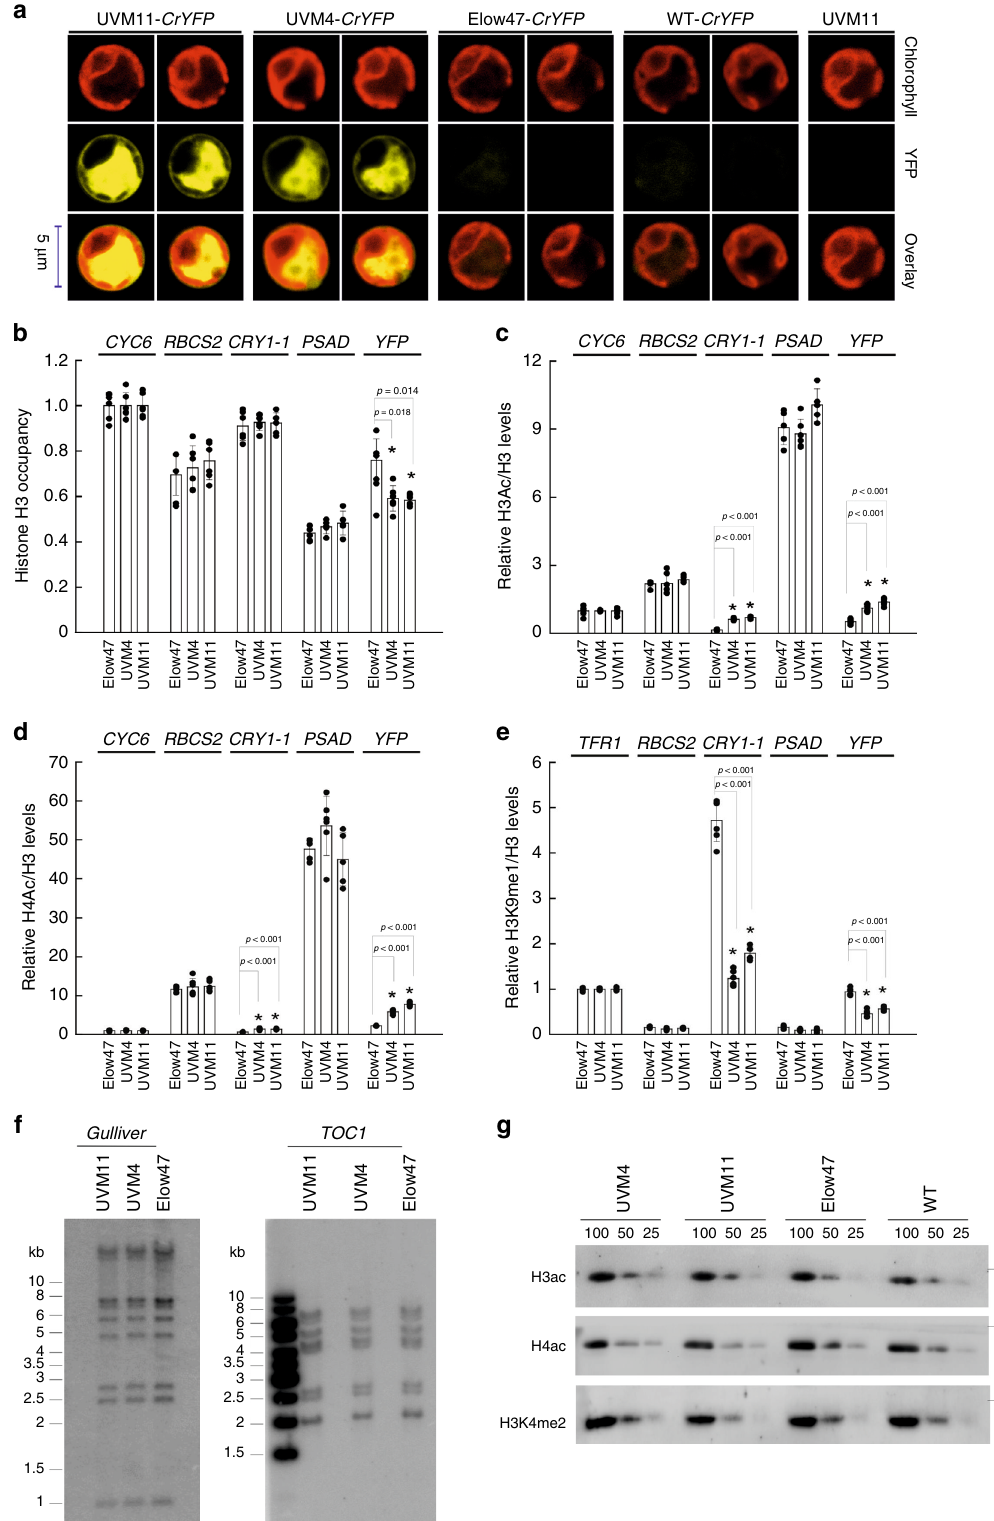
Identi fi cation of the UVM11 and UVM4 mutations . To identify the mutations that cause the expression phenotype of the mutant strains, we sought to pursue a map-based cloning approach 23 . From a cross of the (cell wall-de fi cient, non-motile) strain UVM11 with the wild-type strain CC-124, individual